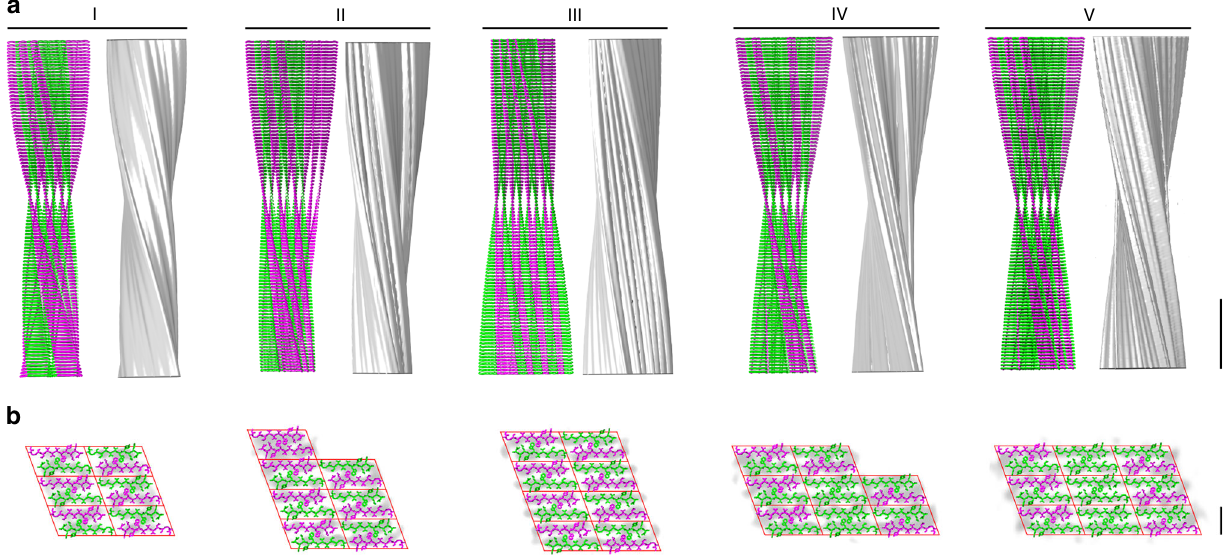
Fig. 3 Peptide assembly of fi bril morphologies I to V. a Side-by-side presentation of the experimentally obtained density and of the peptide assembly of fi bril morphologies I to V (scale bar, 10 nm). b Peptide cross-sections showing an exposed N terminus (magenta) and those not exposed (green) within one peptide layer, superimposed with reconstructions (gray) and fi ltered to 10 Å. Side-chain conformations were not determined by experiments and represent only conformations that are compatible with the packing shown here. The 3D map of morphology I was included as published 8 (scale bar, 2